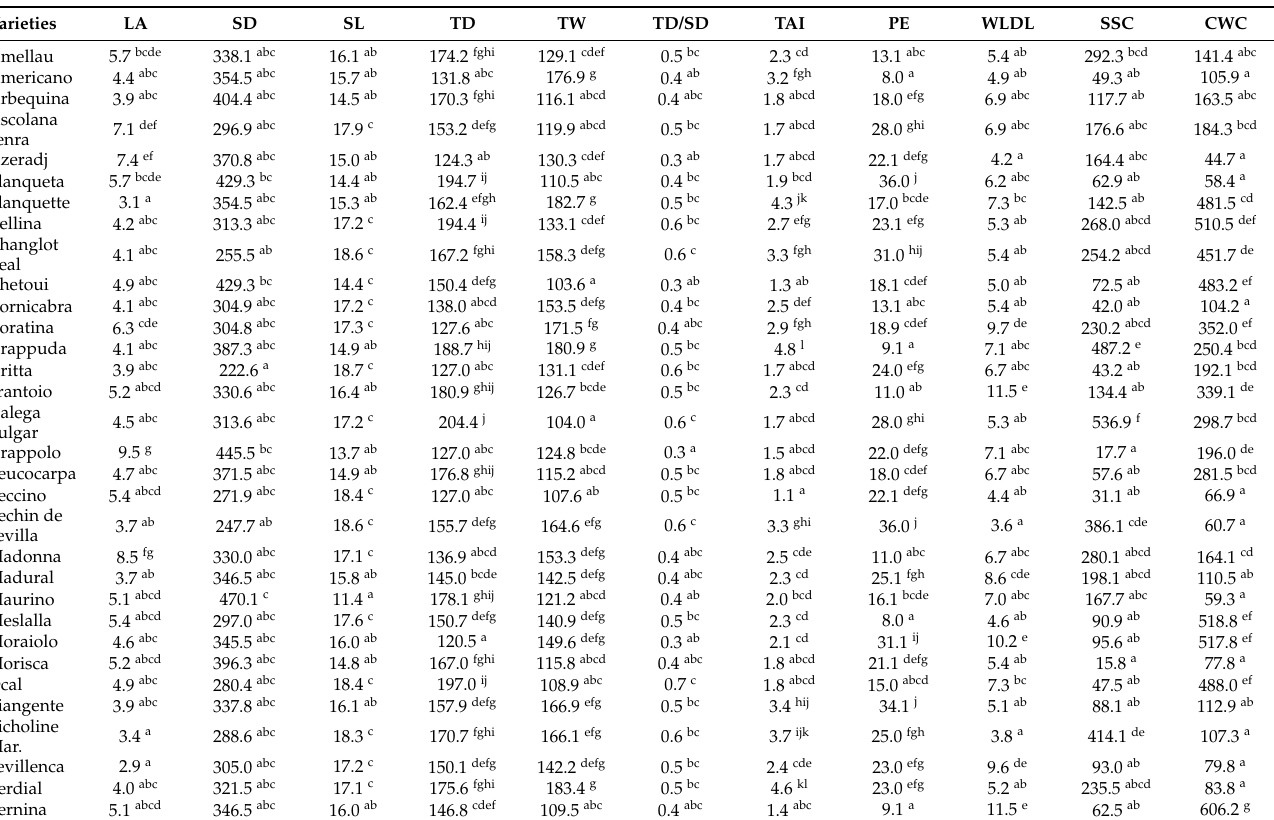
Table 3. Mean values of leaf area (LA, cm 2 ), stomatal density (SD, n mm 2 ), stomatal length (SL, µ